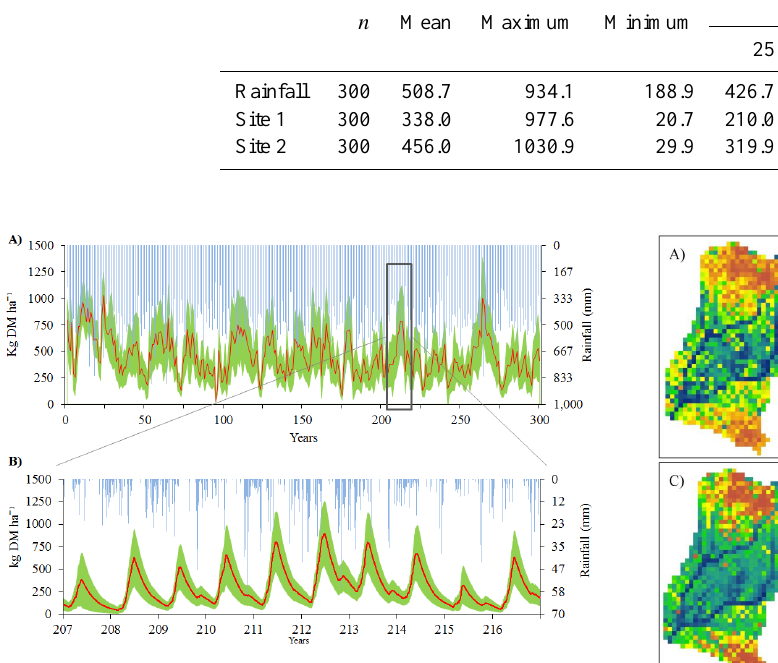
Fig. 9. Simulated average pasture production and precipitation at site 2; (A) at the annual timescale for 300years; (B) for ten years at the daily timescale (the green shade represents ± 1 standard devia- tion of pasture production, and the blue bars is the rainfall).